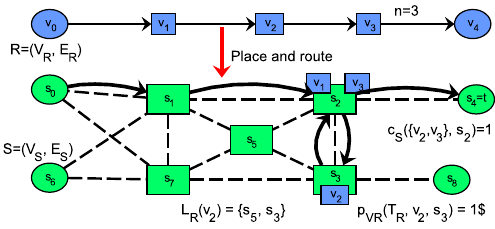
Figure 2. Demonstration of placing a path request graph, meeting the constraints of Formulation